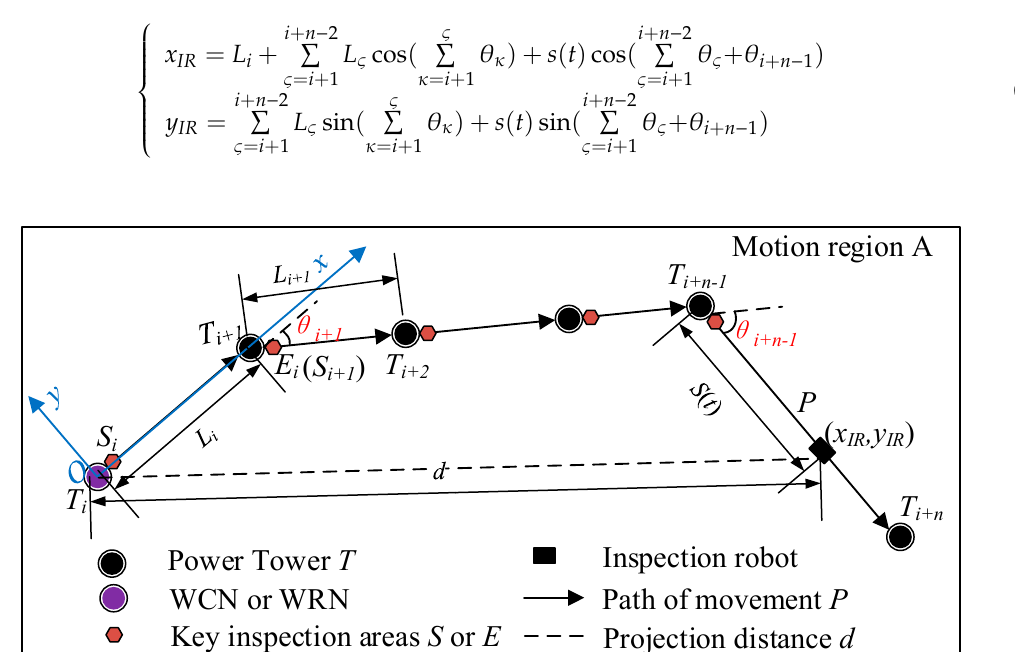
Figure 5. Distance calculation based on robot inspection movement models.